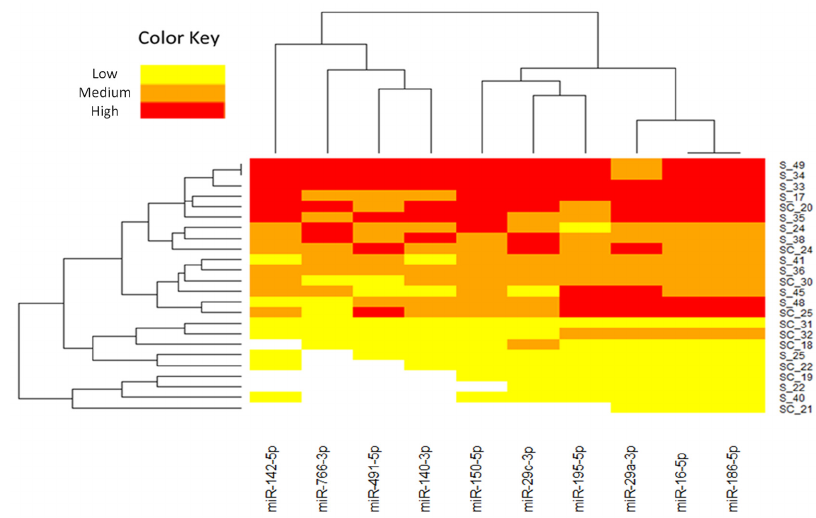
Figure 1. Hierarchical clustering heatmap of 10 miRNAs selected for the validation phase with a > 1.5-fold change difference ( p < 0.05) between CRC patients and healthy controls. Each row represents one sample and each column represents the expression profile of a single miRNA. The relative miRNA expression changes are expressed by three colors from red to yellow, as shown at the top, where red represents the high expression, orange medium expression, and yellow low expression. The miRNA clustering tree is shown on the top and the sample clustering dendrogram is presented on the left. S1–S12 correspond to salivary samples of CRC patients and SC1–SC10 correspond to salivary samples of healthy controls. Note: miRNAs, microRNAs; CRC, colorectal cancer. J. Clin. Med. 2019 , 8 , 2029